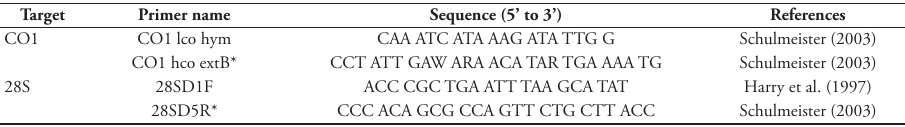
Table 2. Primer information for